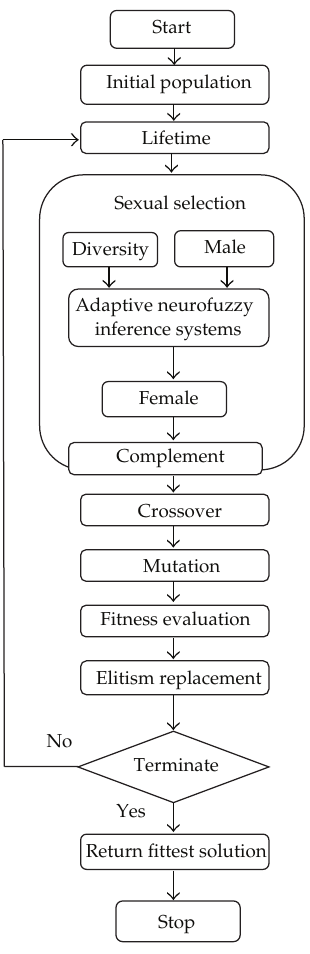
Figure 1: Framework of neurofuzzy inference systems genetic